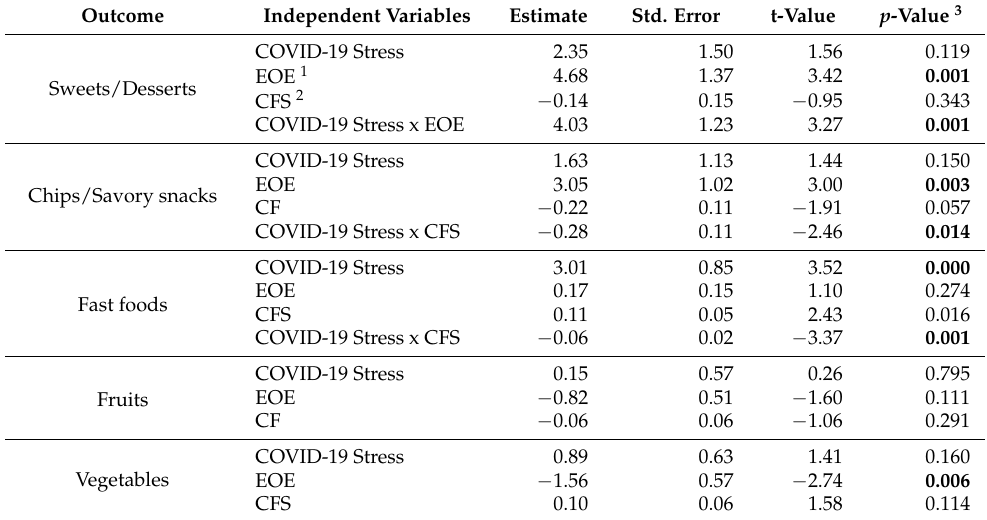
Table 4. Best-fit multivariate linear regression models of COVID-19-related stress, emotional overeat- ing, and cognitive flexibility associated with food intake frequency during COVID-19 ( n = 428). Outcome Independent Variables Estimate Std. Error t-Value p -Value 3